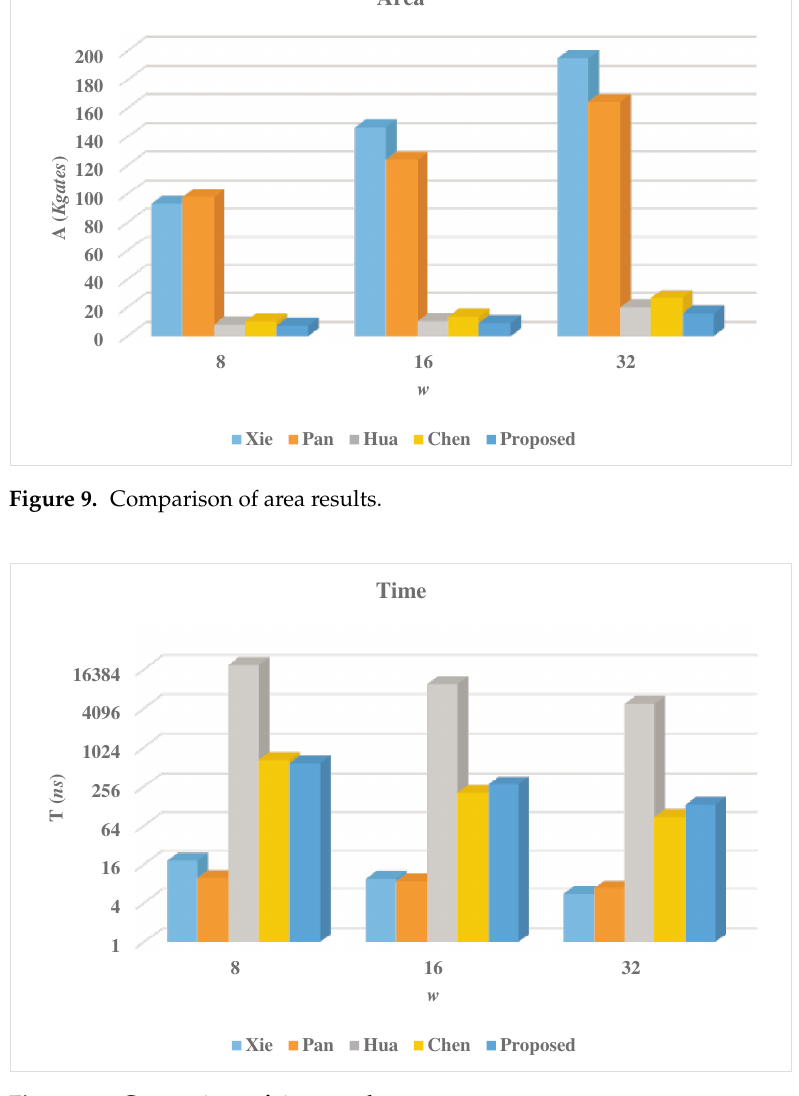
Figure 10. Comparison of time